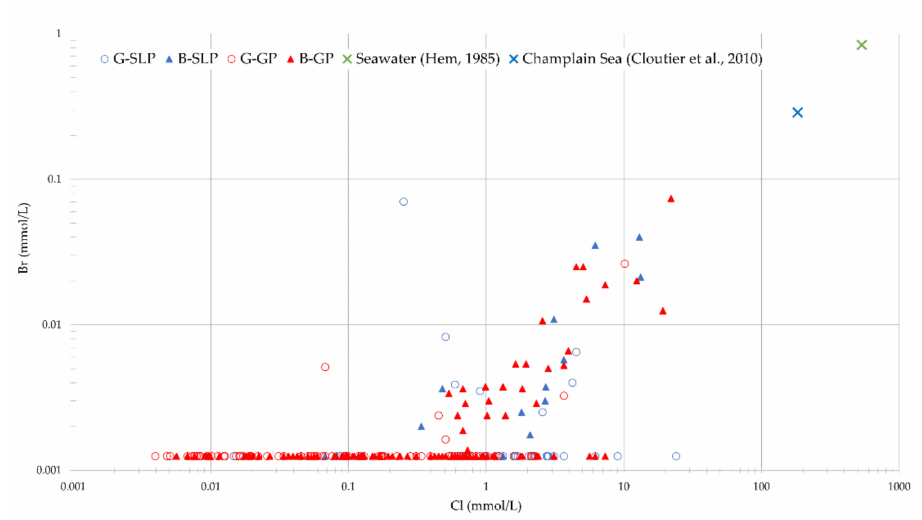
Figure 4. Binary diagram plotting Br – vs. Cl − vs. in mmol/L. Samples are represented according to their geological province and their type of aquifer. The green cross X represents the composition of average seawater [40]. The blue ‘x’ represents the composition of the Champlain Sea